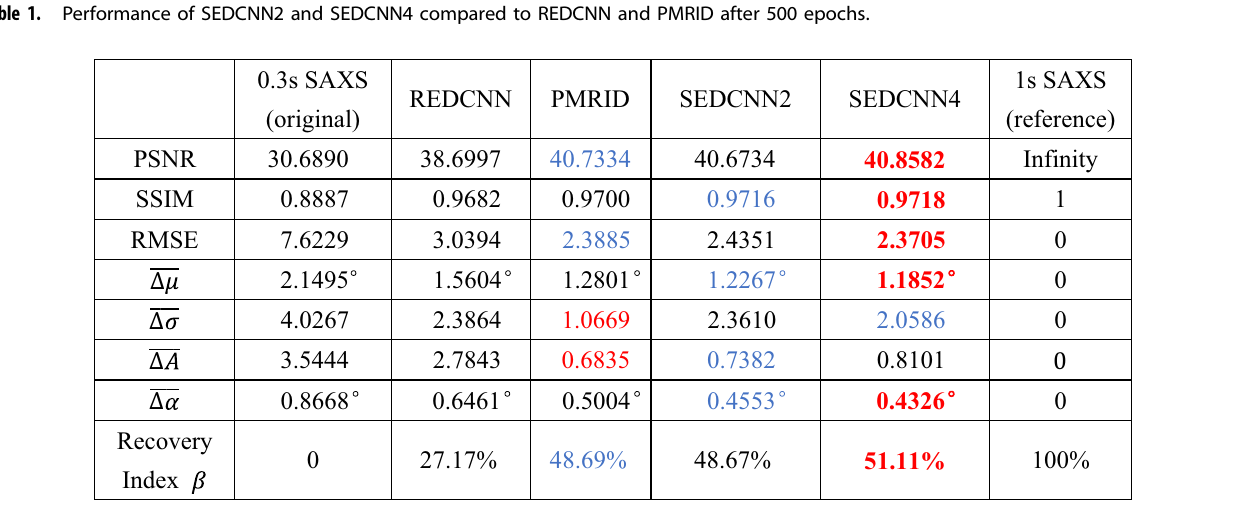
Red colored values indicate best performer; blue values indicate the second best performer. The bold red color indicates best performance was achieved on our SEDCNN (direct angle) differences represented as Δ μ , Δ σ , Δ A , and Δ α , respectively. Detailed de fi nitions on these metrics can be found in “ Methods ” . We obtained the performance shown in the following table (Table 1), where the “ 1 s SAXS ” column refers to the reference (clean) dataset with an exposure time of 1 s. The “ 0.3 s SAXS ” column refers to the original noisy data with an exposure time of 0.3 s. We highlight the best-performing results in red, with the second place marked in blue. To better visualize the effectiveness of denoising using our SEDCNN model, we randomly selected one image pair from the testing dataset and compared the radial integration of the original